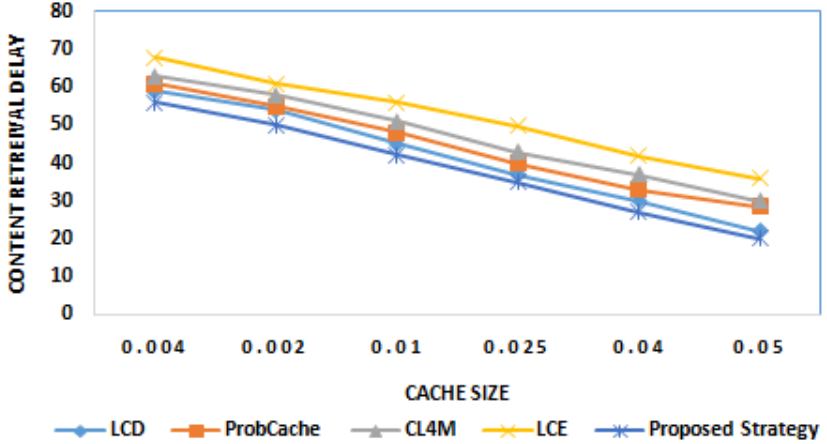
Figure 4. Content retrieval delay for different cache sizes.